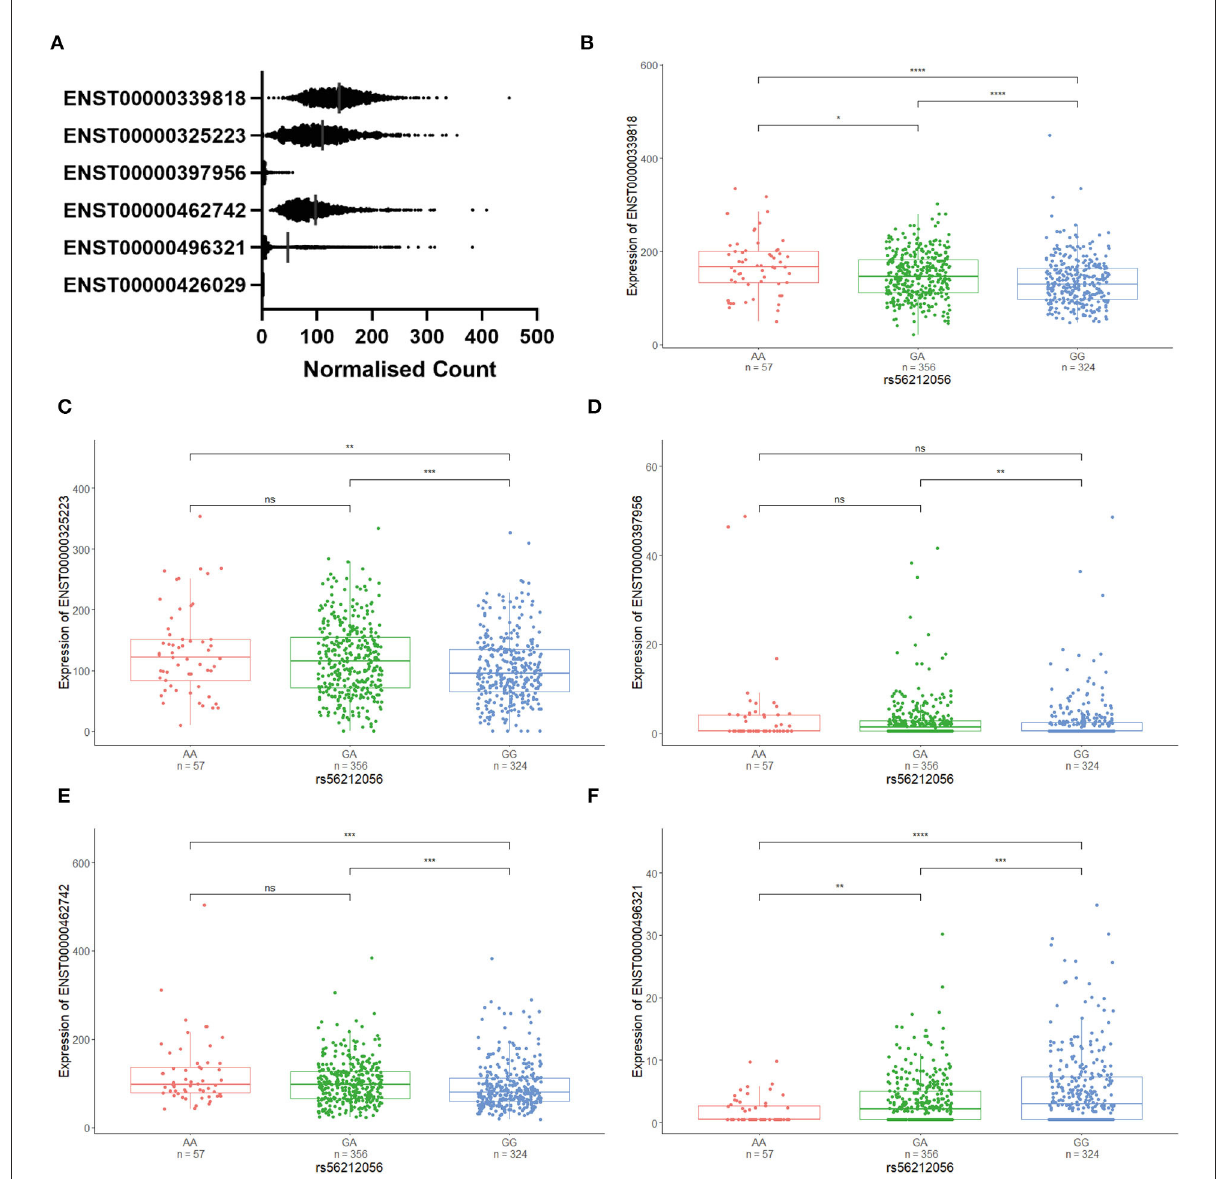
FIGURE5 The expression of CFAP410 isoforms is associated with tagging the SNP rs56212056 genotype. (A) CFAP410 isoform expression using RNAseq data from the NYGC Target ALS cohort. (B–F) Association of three different SNP genotypes (AA, GA, and GG) with an expression of isoforms ENST00000339818, ENST00000325223, ENST00000397956Q24, ENST00000462742, and ENST00000496321 was analysed based on the correlation with allele 4 (A) or allele 5 (G) using transcriptomic data from the NYGC ALS cohort. Wilcoxon test was applied to demonstrate statistical significance indicated as asterisks. * P = < 0.05, ** P = < 0.01, *** P = < 0.001, **** P = < 0.0001, ns >